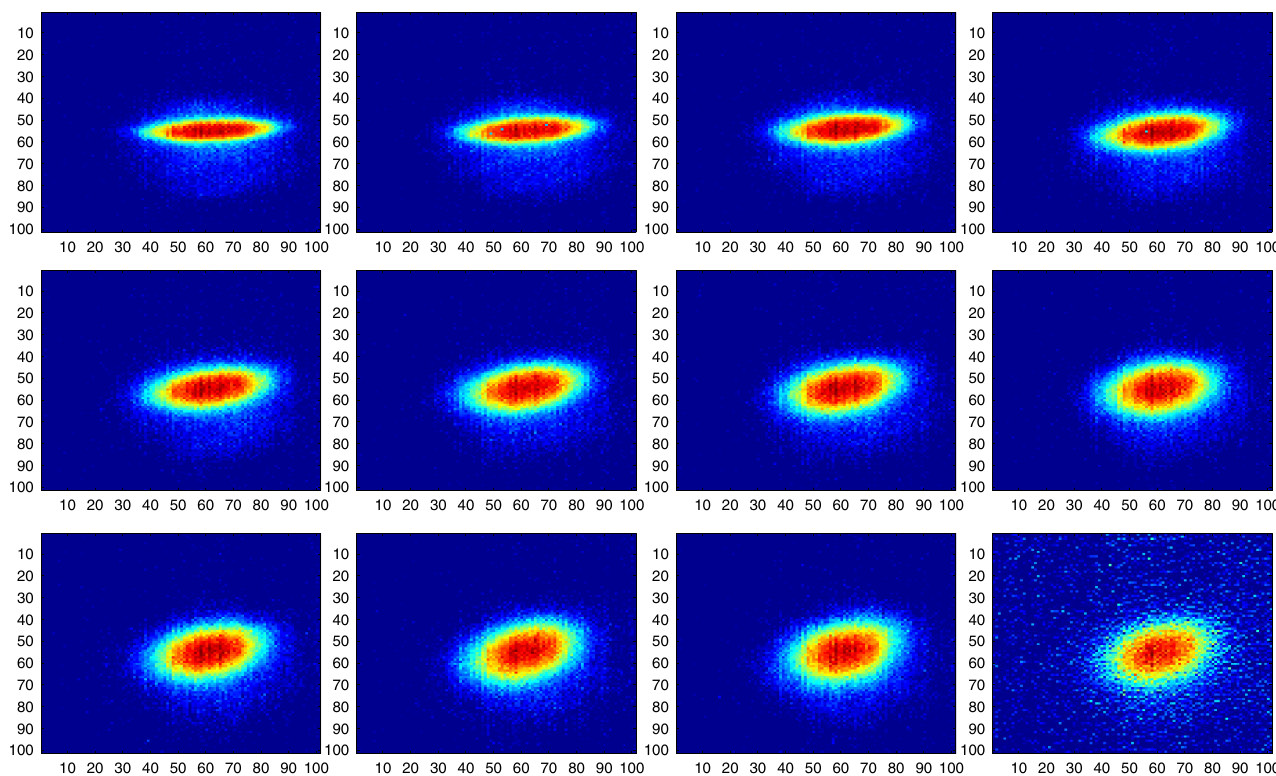
FIG. 8. Comparison of XDB images for each coupling setting. Minimal coupling is the top left image, and 1% coupling is in the bottom right. The coupling increases left to right, top to bottom.